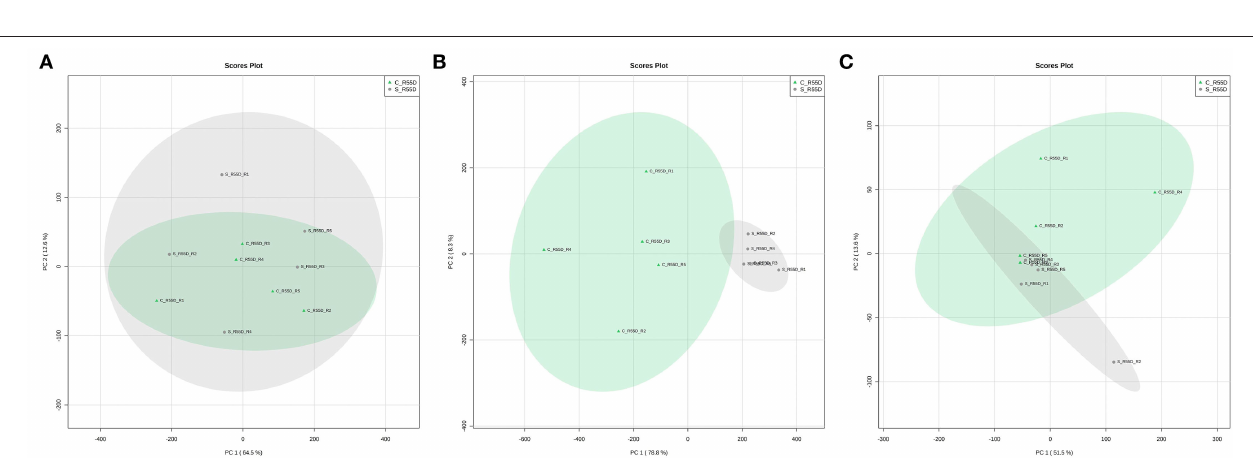
FIGURE 3 | Summary of the pathway analysis of the data from leaves—STS (A) and LTS2 (B) —using the Pathway Topology Analysis modules of MetaboAnalyst 5.0. The metabolome view resulted from the analysis in the Pathway Topology Analysis module using the Hypergeometric test, the relative betweenness centrality node importance measure, and the latest KEGG version of the A. thaliana pathway library. STS, Short-term stress (the control and the stressed plants at 2 DAT); LTS2, Long-term stress 2 (the stressed plants at 2 and 55 DAT). Pathway impact takes into account both node centrality parameters—betweenness centrality and degree centrality—and represents the importance of annotated compounds in a specific pathway.